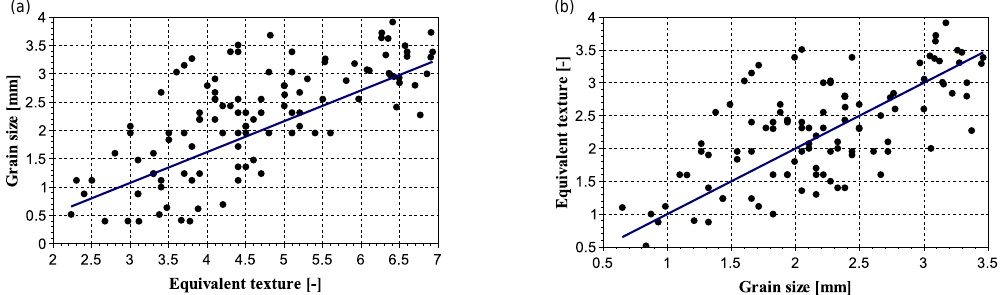
Figure 1. Calibration (a) and validation (b) data set for the predictive relationship between the surface grain size and the picture texture (entropy). A simple linear equation is used. The error estimation on the validation data set is 0.38mm on the absolute mean value and 0.61mm for standard deviation of the absolute value.